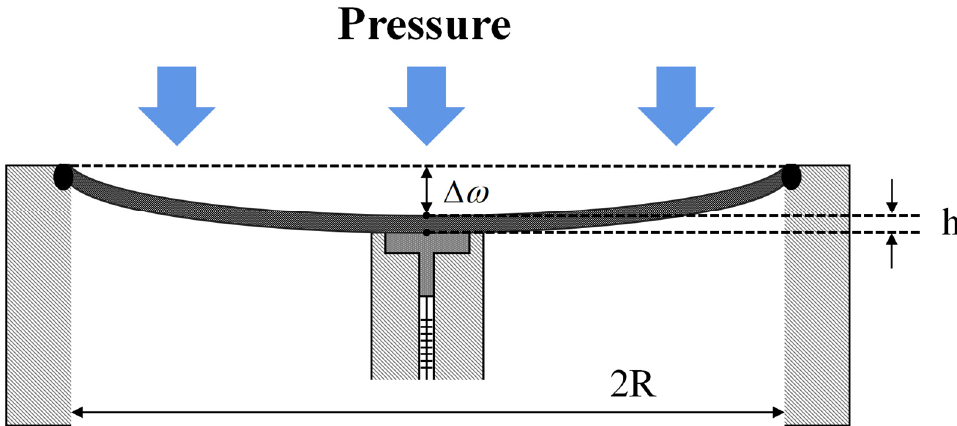
Figure 3. Schematic diagram of diaphragm compression deformation.